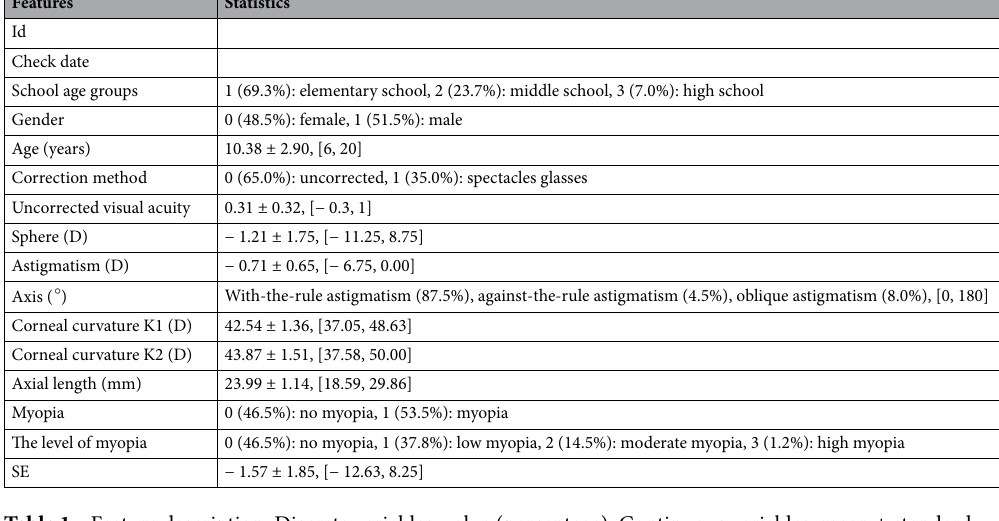
Table 1. Feature description. Discrete variables: value (percentage). Continuous variables: mean ± standard deviation, [min, max]. Axis values follow a bimodal distribution, so the mean value and standard deviation are less meaningful. Therefore, we treat it as a quasi-categorical variable with three classes: with-the-rule astigmatism ( Axis < 30 ◦ or Axis > 150 ◦ ), against-the-rule astigmatism ( 60 ◦ ≤ Axis ≤ 120 ◦ ), and